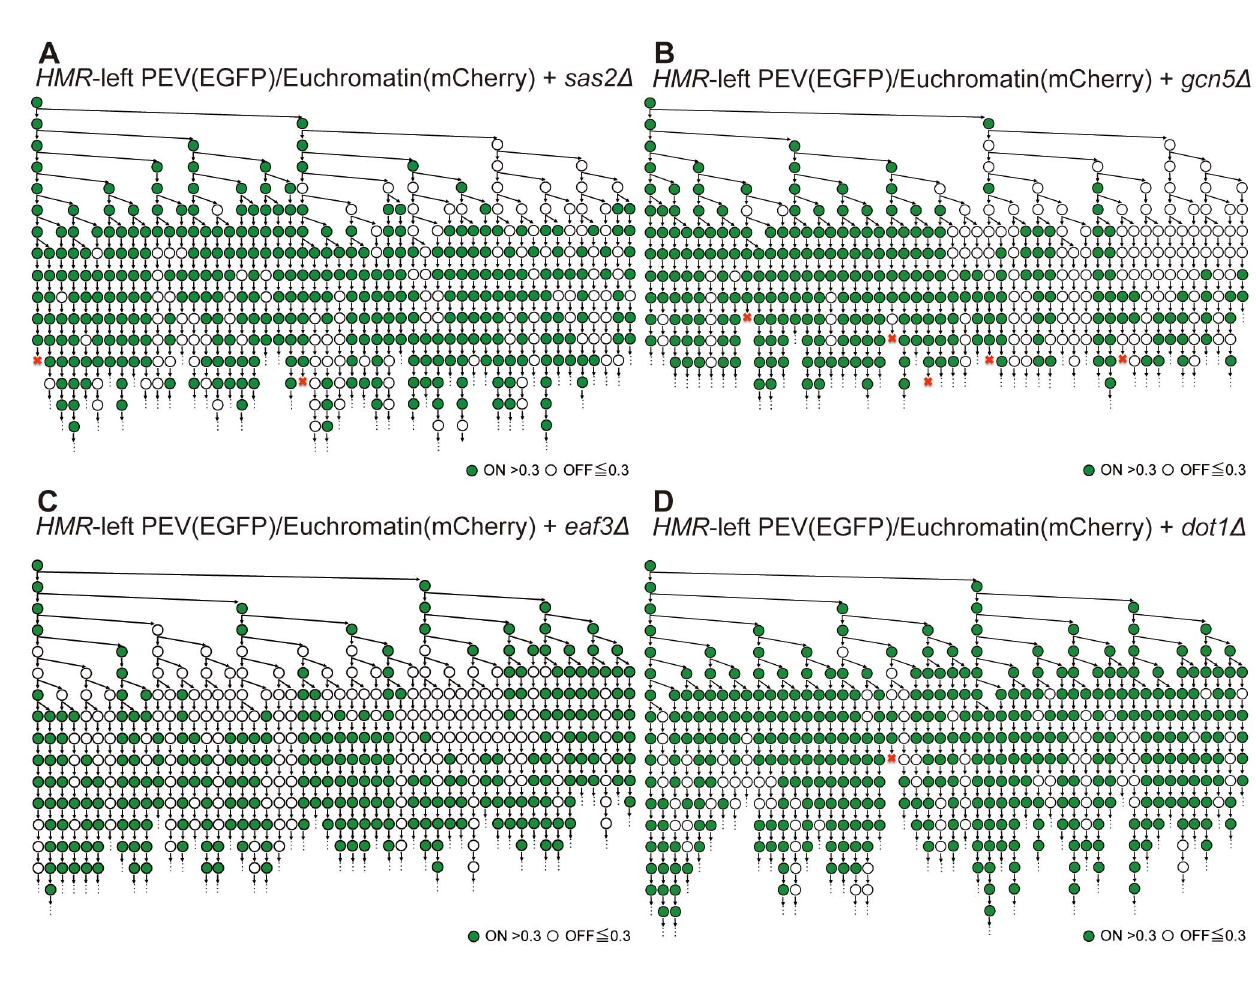
Figure 7. Representative expression lineage trees derived from a single cell of histone modification enzyme deletion strains. (A 2 D) The fluorescence intensities of single cells from HMR -left PEV/Euchromatin + sas2 D (FUY358) (A), HMR -left PEV/Euchromatin + gcn5 D (FUY797) (B), HMR - left PEV/Euchromatin + eaf3 D (FUY799) (C), and HMR -left PEV/Euchromatin + dot1 D (FUY801) (D) strains were tracked in real time. The highest positioned circle on the left side of each panel indicates the first single cell; vertical arrows indicate the division and lineage of the mothers, whereas downward or horizontal arrows identify the daughter cells of specific mothers. Green cells indicate a fluorescence intensity . 0.3 and white cells indicate an intensity , 0.3. Dead cells are indicated by a red X. Not every cell is shown on this tree because of spatial constraints. Every cell was counted and the data are summarized in Table S6.